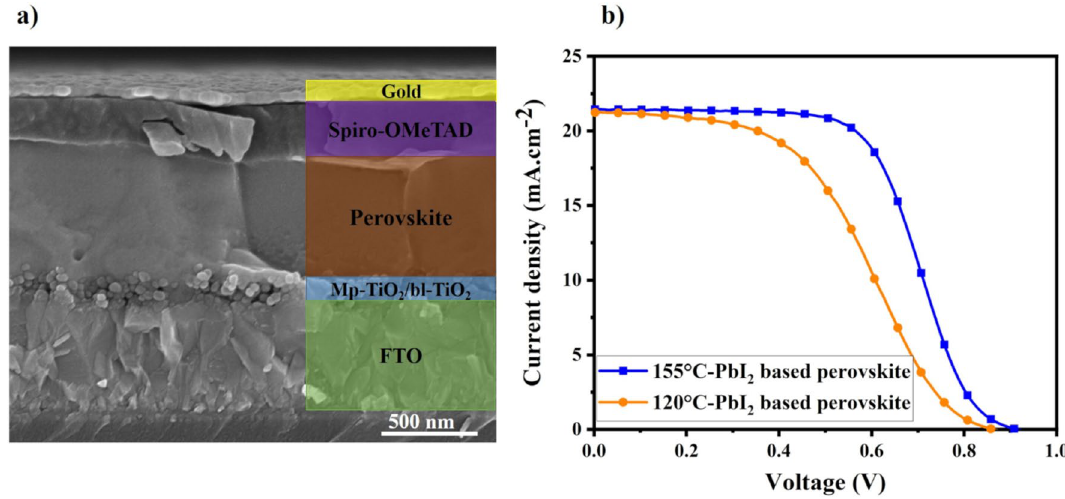
Figure 8. ( a ) Cross section SEM image of a FTO/bl-TiO 2 /mp-TiO 2 /perovskite/Spiro-OMeTAD/Au solar cell. ( b ) Current–voltage characteristic of the best-performance devices based on 120 °C-PbI 2 and 155 °C-PbI 2 .